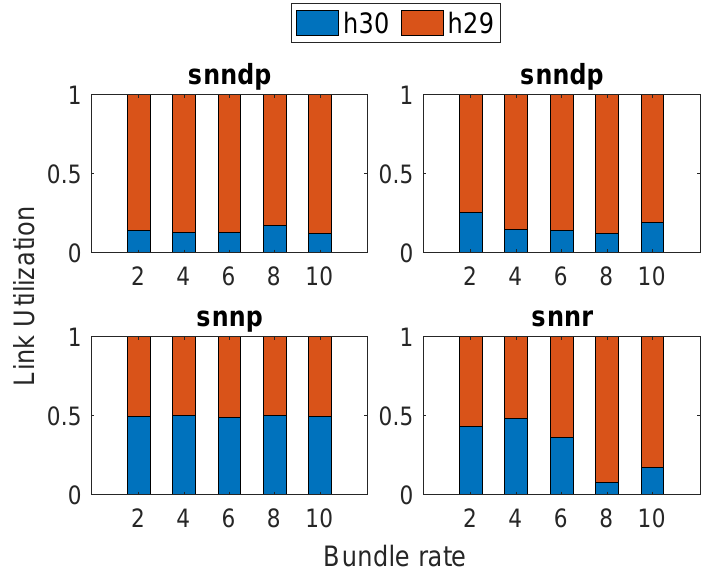
Figure 12. Link selection at Node h26: Scenario 5.